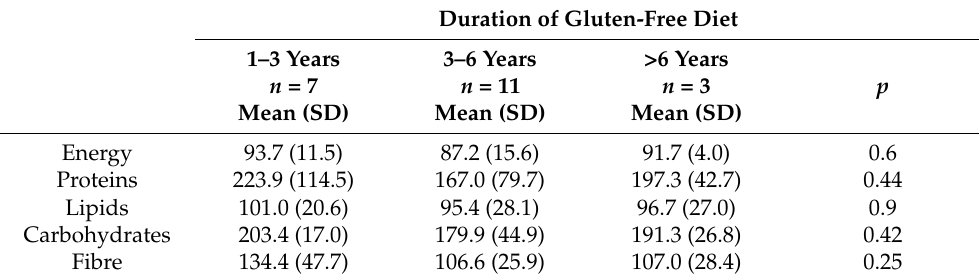
Table 8. Percentage of dietary reference intake (%DRI) for total energy and macronutrients in coeliac patients with regard to the duration of the gluten-free diet.